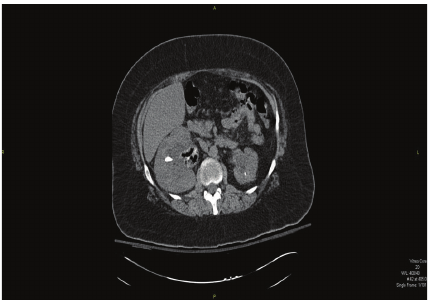
Figure 1: CT scan of the abdomen and pelvis showing marked right hydronephrosis with calculi, perinephric fat stranding, and gas in the renal pelvis.